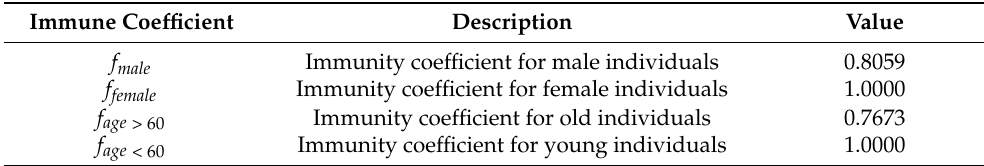
Table A4. The set value of the immunity coefficient.